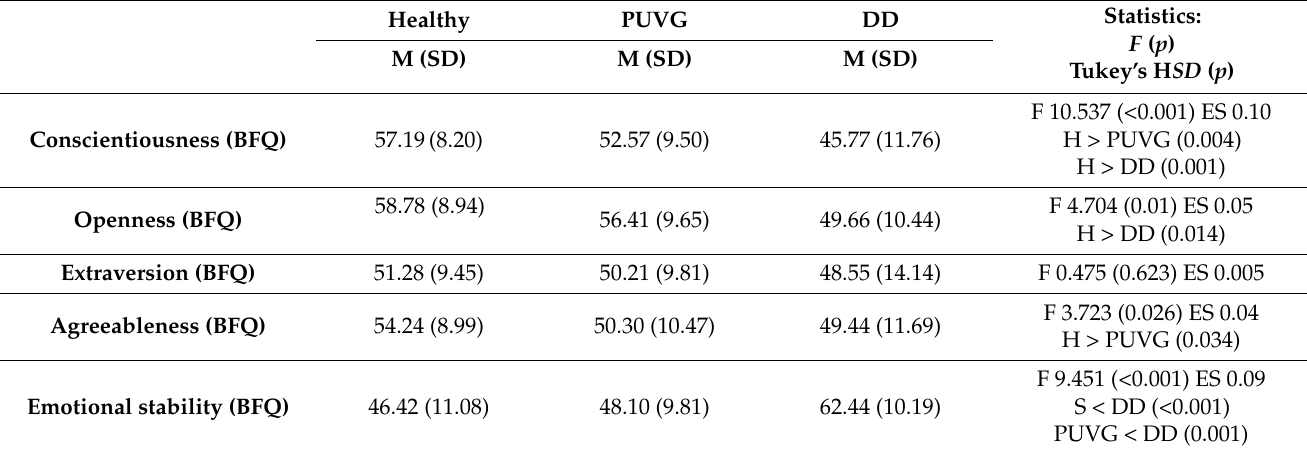
Table 2. Personality characteristics of the adolescents included in the study ( N = 223).